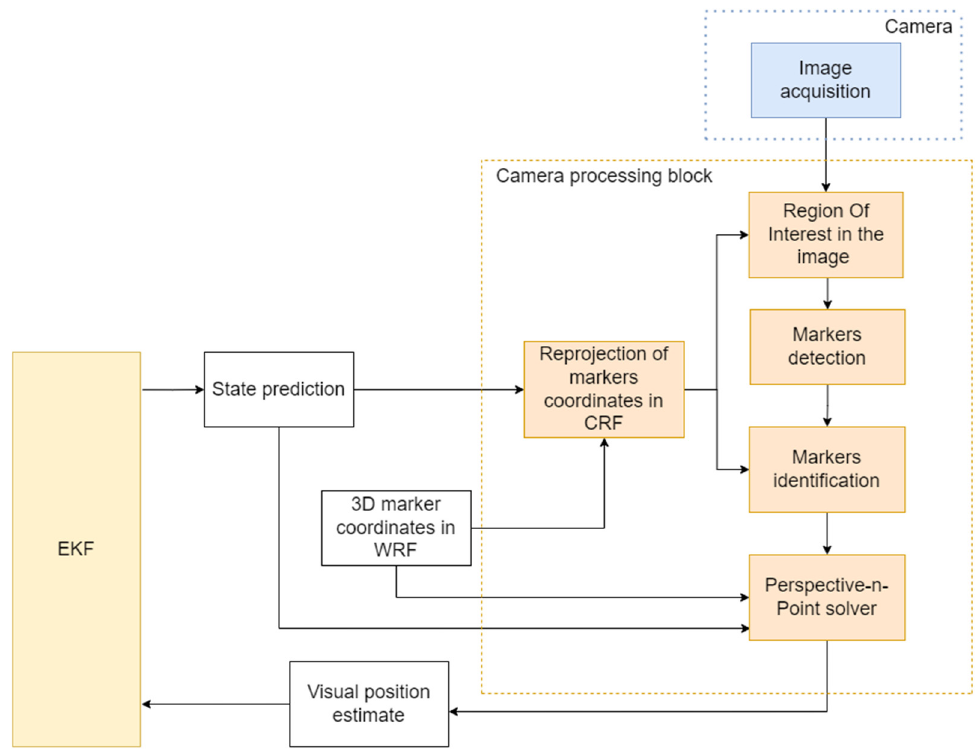
Figure 5. Flowchart of the camera processing algorithm.